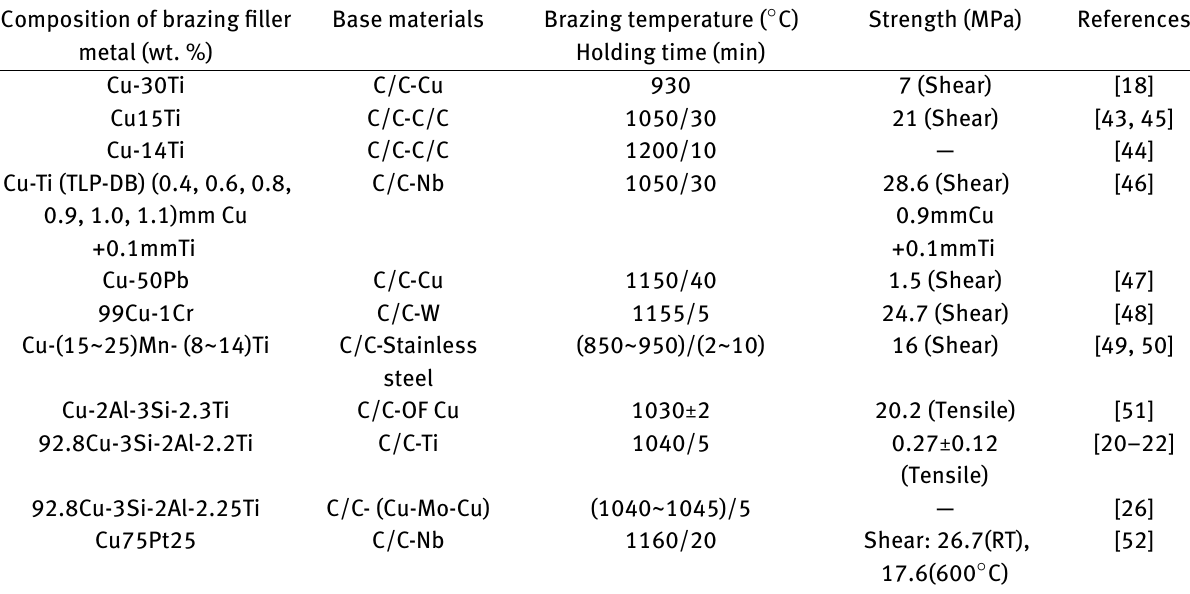
Table 3: Cu-based brazing filler metals used in joining of C/C composites Composition of brazing